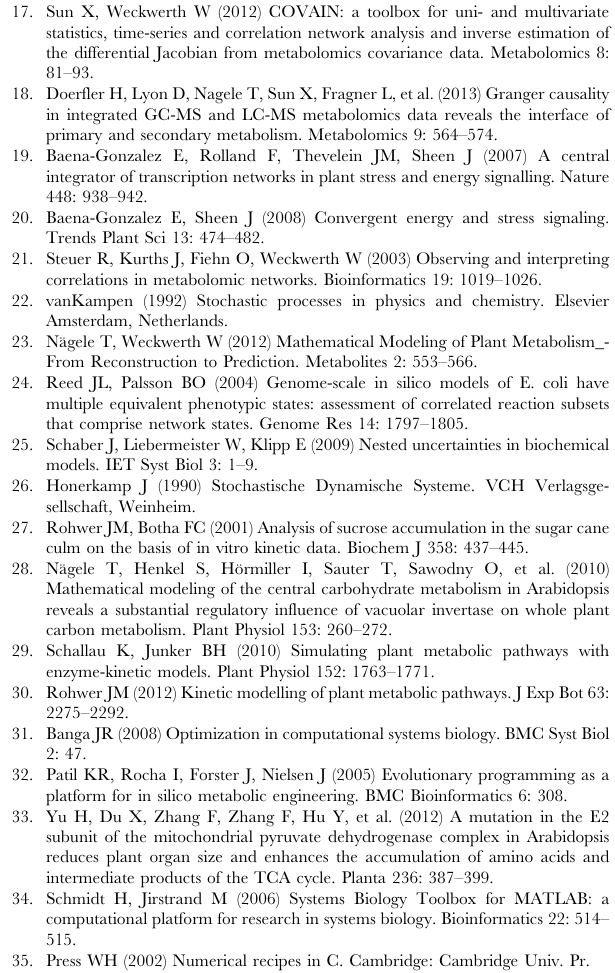
Table S1 Metabolomics data. GC-MS data, mean and cluster-analysis results. Model S1 Metabolic reconstruction of genome-scale superpathways adapted to metabolite profiling data for Arabidopsis thaliana (see Materials and Methods). Model S2 ODE model global optimization